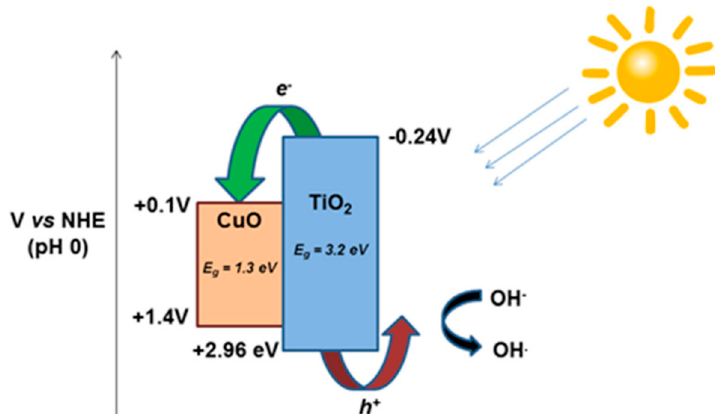
Figure 8. Mechanism of charge transfer in CuO/TiO 2 heterojunction. Reprinted with permission from [90]. Copyright John Wiley & Sons, Inc., 2015.